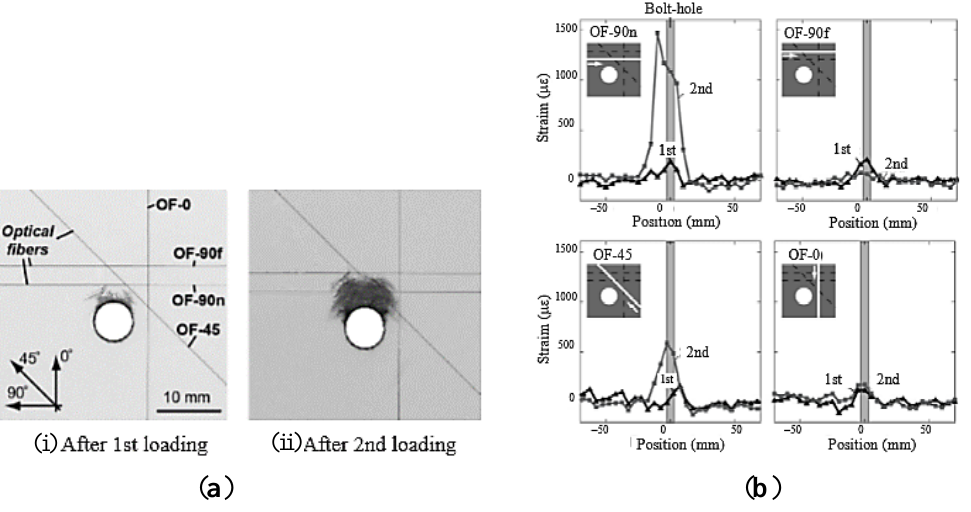
Figure 25. Optical fibres deployment and damage around the CFRP bolted joint ( a ); residual strain distribution along the optical fibres after loading ( b)